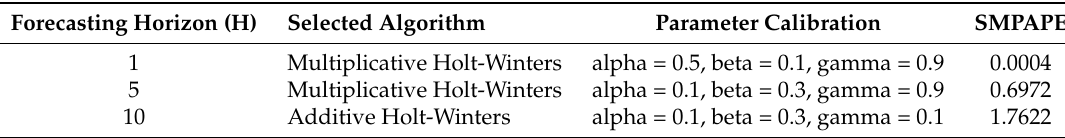
Table 12. Forecasting results for each